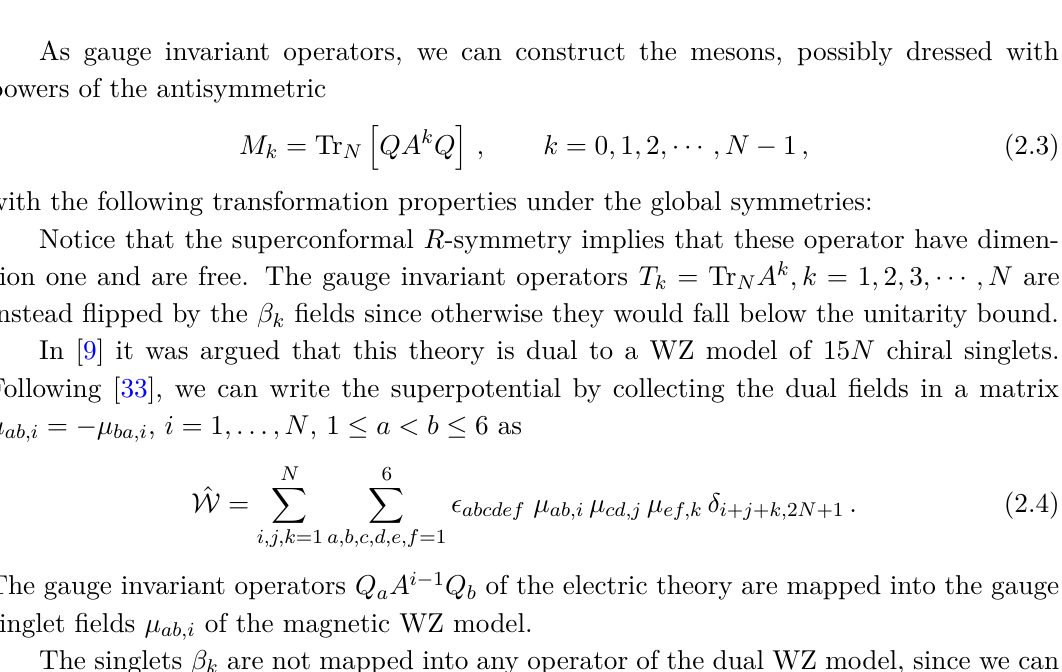
Table 2 . Transformation properties of the gauge invariant